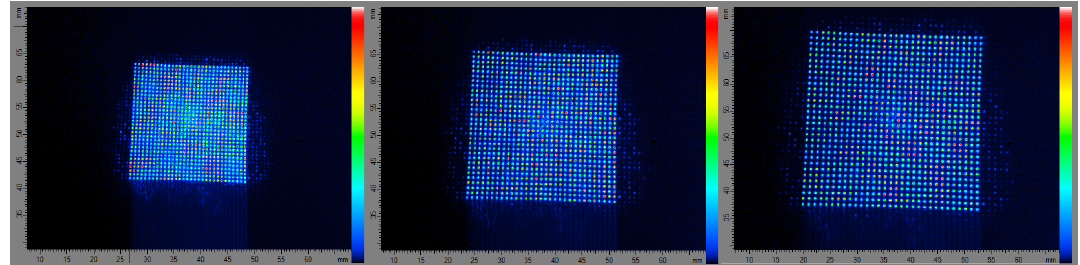
Figure 5. Projection of regular laser grid (31 × 31 individual spots) at a working distance of 50, 65 and 80mm (from left to right) with a uniformity of 10% regarding the size and intensity of each point.